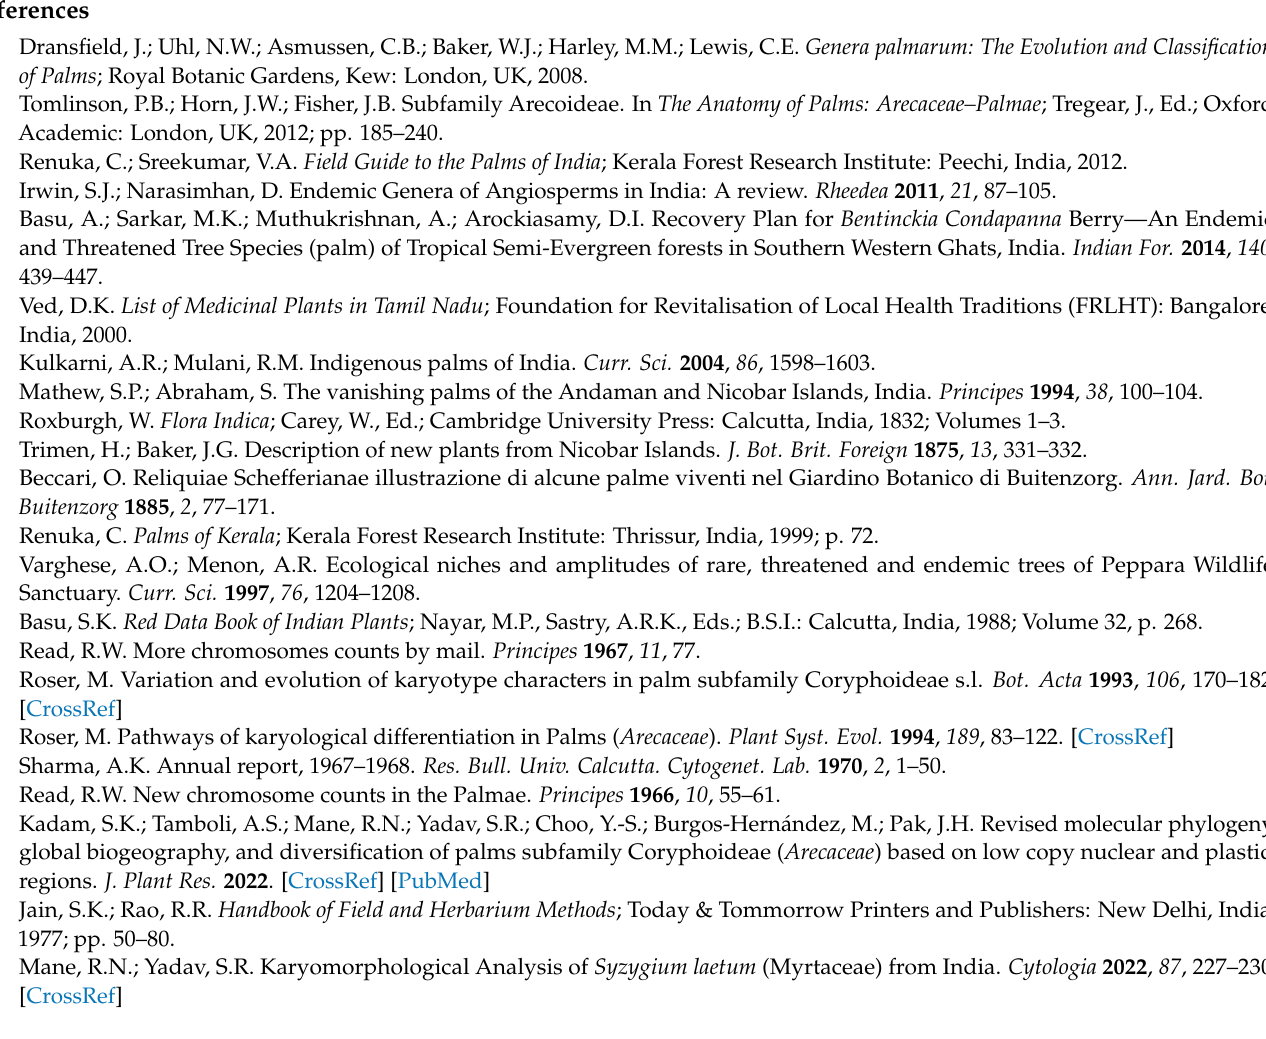
Supplementary Table S1: Voucher information and GenBank numbers (PRK, RPB2, rbc L, rps 16, mat K, ndh F, rpo C1 acc D, and trn L-F) for all accessions used in this study. The sequences generated in this study are marked with * and — represent missing